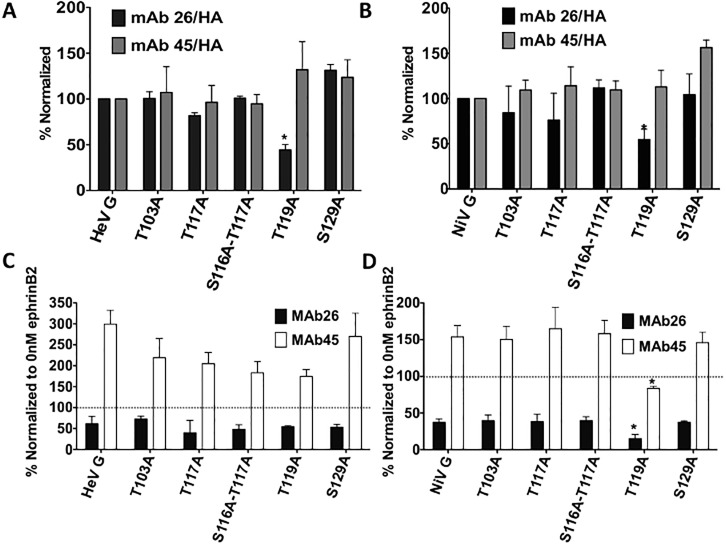
O-glycan loss can affect HNV G conformation.A & B) Normalized mAb binding to wt or mutant HeV G (A) or NiV G (B). All antibody binding levels are normalized to the CSE of each mutant (as measured by HA levels). N = 3. C & D) Conformational changes of wt or mutant HeV G (C) or NiV G (D) as measured by Mab45 (white) and Mab26 (black) upon the addition of 100nM ephrinB2. All values are normalized to antibody binding levels when no (0nM) ephrinB2 was added. Averages and standard deviations are shown. N = 3. Statistically significant differences, as determined by a Student’s t-test, are marked with an asterisk (p<0.05).